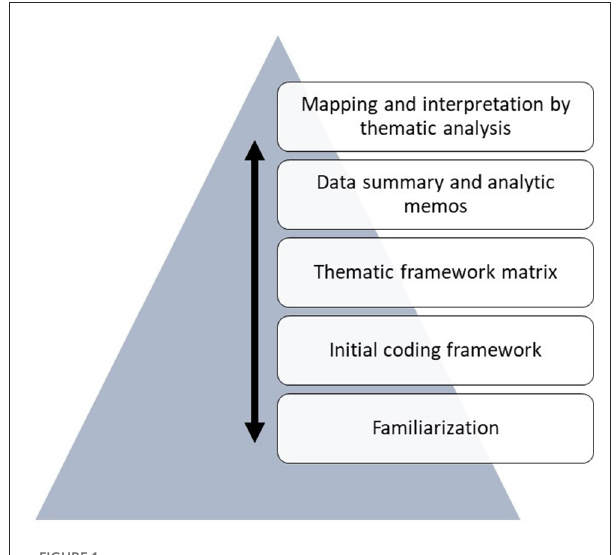
FIGURE1 Illustration of the hierarchy and the flexible workflow between the stages of the framework analysis procedure, moving back and